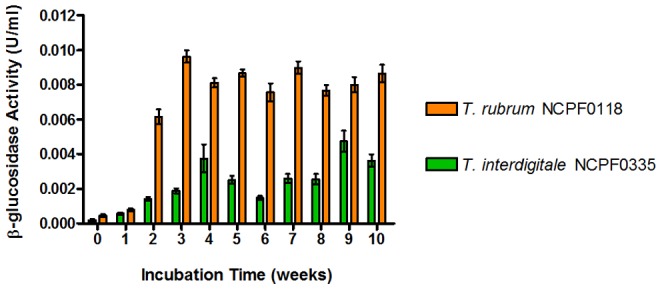
Determination of β-glucosidase activity by T. rubrum NCPF0118 and T. interdigitale NCPF0335 over a 10 week incubation period.β-glucosidase activity was determined from triplicate 100 µl cell pellets, and results are representative of triplicate experiments. Error bars represent the standard deviation of the mean.